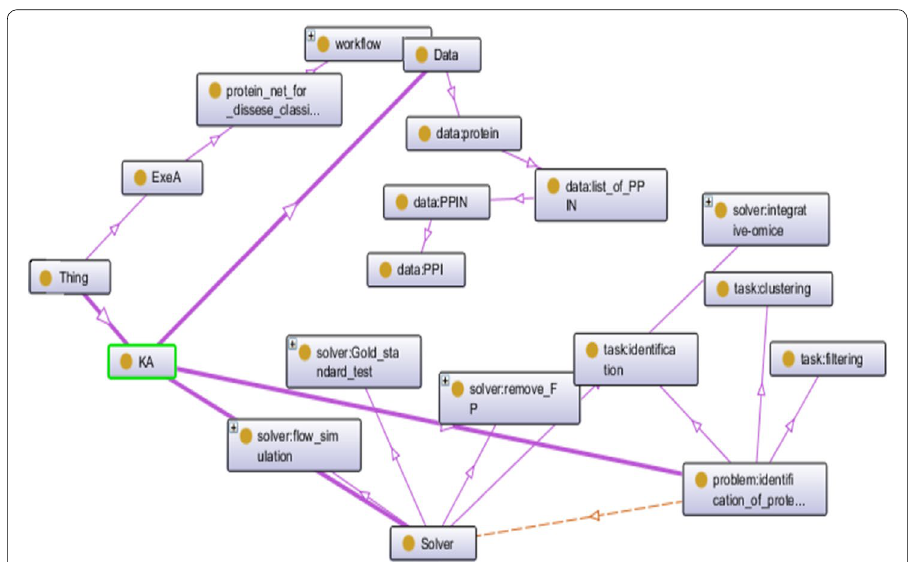
Fig. 1 Example of a scientific workflow